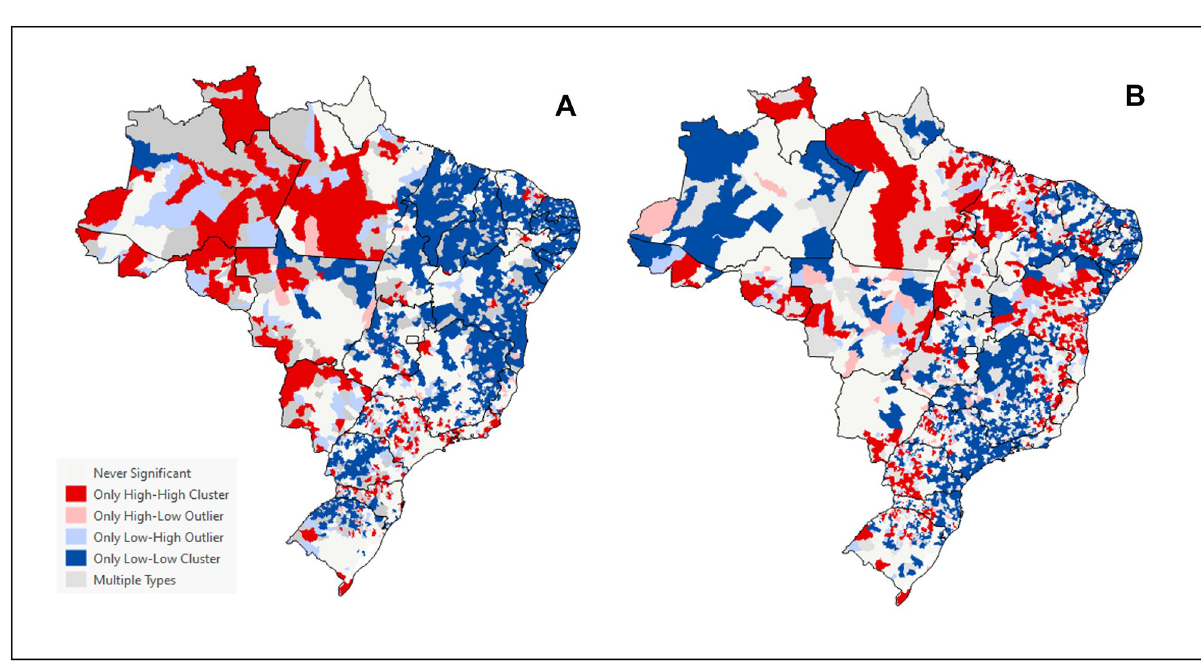
Fig 3. Local outlier analysis of PCSC related to prenatal care and childbirth and in children under two years old. Brazil, 2008–2019. (A) PCSC in women, for causes related to related to prenatal care and childbirth. (B) PCSC in children under two years of age.